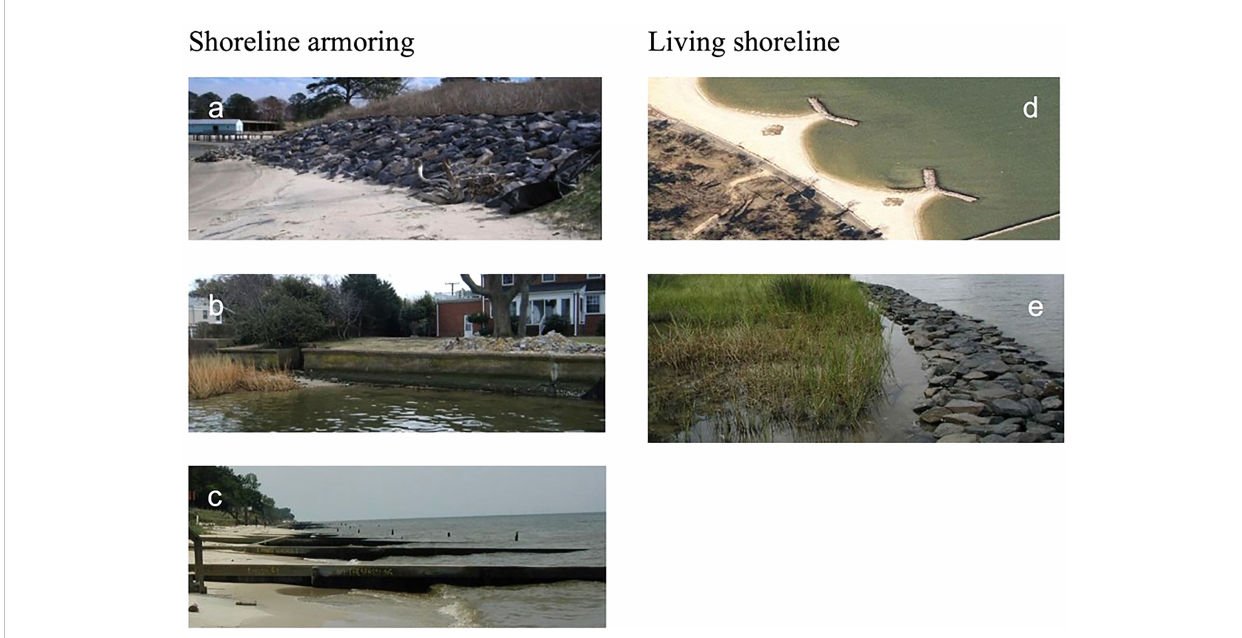
FIGURE 1 Shoreline modi fi cation types Shoreline modi fi cation types that were de fi ned in the survey with the accompanying pictures of (A) riprap revetment, (B) bulkhead, (C) groins, which are classi fi ed as shoreline armoring and (D) breakwaters, (E) marsh with a rock sill, which are classi fi ed as living shorelines. Photo credits from the Center for Coastal Resources Management, Virginia Institute of Marine